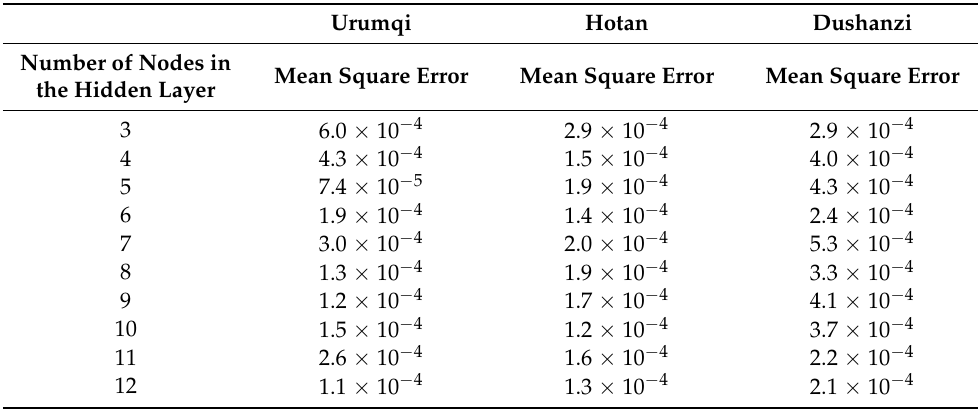
Table 2. The process of determining the number of nodes in the implicit